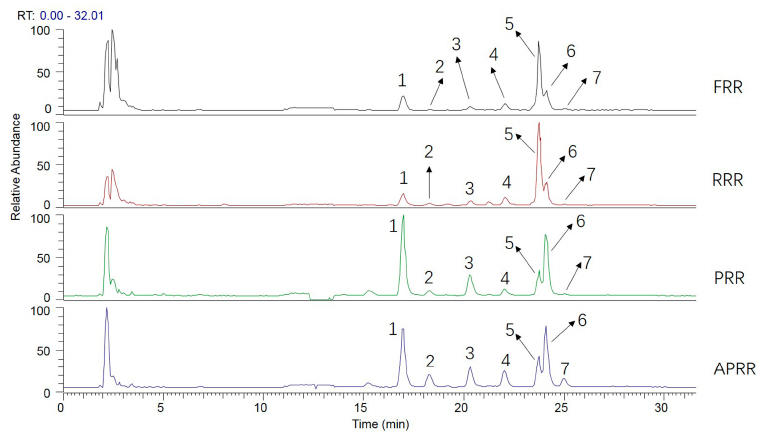
Figure 4. Total ion chromatogram (TIC) of four kinds of RRs in positive ion mode using UHPLC-LTQ-Orbitrap-MS.